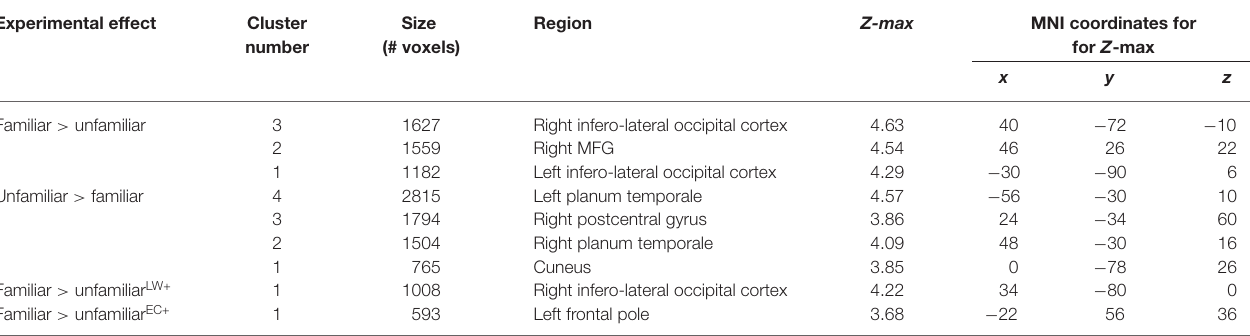
TABLE 1 | MNI Coordinates and Z -max values for regions with significant main effects for face familiarity and for regions in which love withdrawal and empathic concern interact with effects of face familiarity